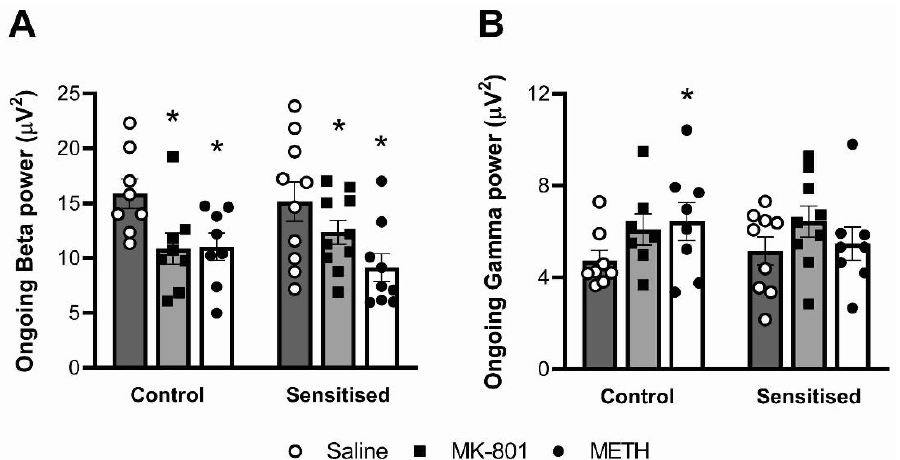
Figure 4. Effects of METH sensitisation and acute drug challenge on ongoing cortical oscillations. The animals were chronically treated with either saline vehicle (Control) or METH (Sensitised) and acutely treated with a saline, MK-801 and METH challenge. ( A ) Ongoing beta power was significantly reduced by acute MK-801 and METH treatment. ( B ) Ongoing gamma power was significantly increased by acute METH. There were no effects of METH pretreatment. * p < 0.05 for difference with acute saline injection. n = 8 control mice; n = 10 sensitised mice.